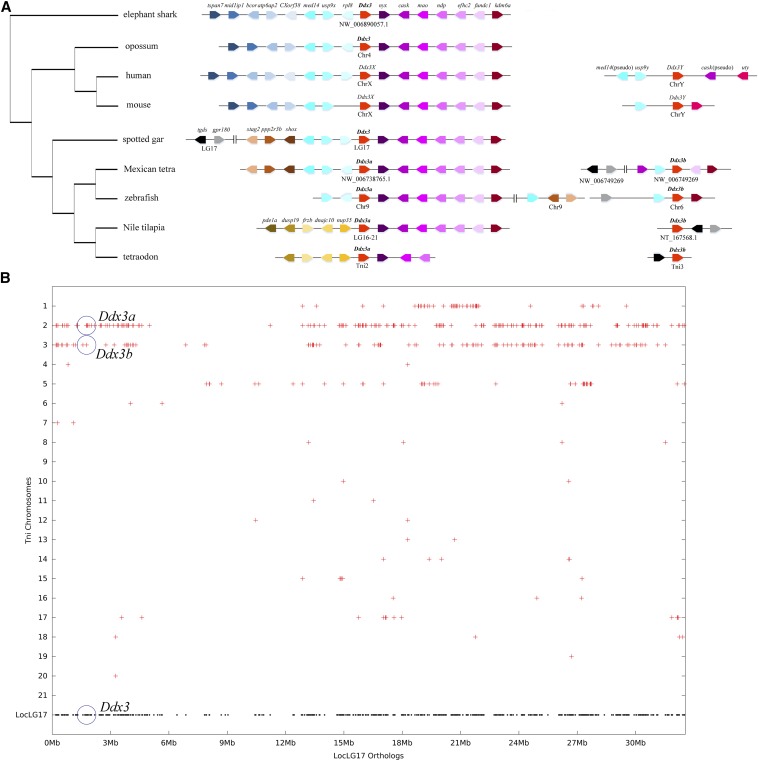
Synteny analyses of vertebrate Ddx3 genes. (A) Illustration of the syntenic relationship among several Ddx3 genes, eutherian DDX3X/Y genes, and teleost Ddx3a and Ddx3b genes. The arrows in different colors stand for different genes and the arrowheads point in the direction of the corresponding gene. Gene order was determined according to their relative positions in the same chromosome or scaffold. Vertical lines indicate noncontiguous chromosomal regions. The phylogenetic tree was constructed using the coding sequences of Ddx3, Ddx3a, and Ddx3X from these species by Neighbor Joining method in MEGA6. The Assembly ID at NCBI or Ensembl database was provided in Table S1. (B) Synteny analysis of spotted gar LG17 and tetraodon chromosomes. Spotted gar Ddx3 gene is at LG17.Tetraodon Ddx3a is at Tni2, and Ddx3b is at Tni3.